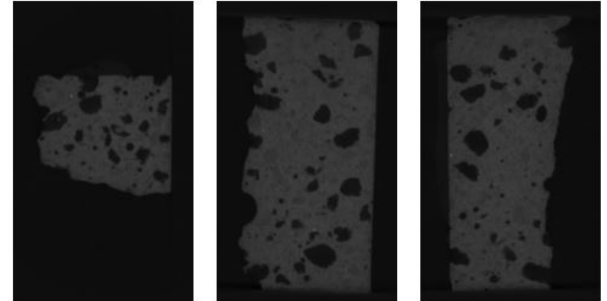
Figure 13 – µCT images of all 3 planes of a